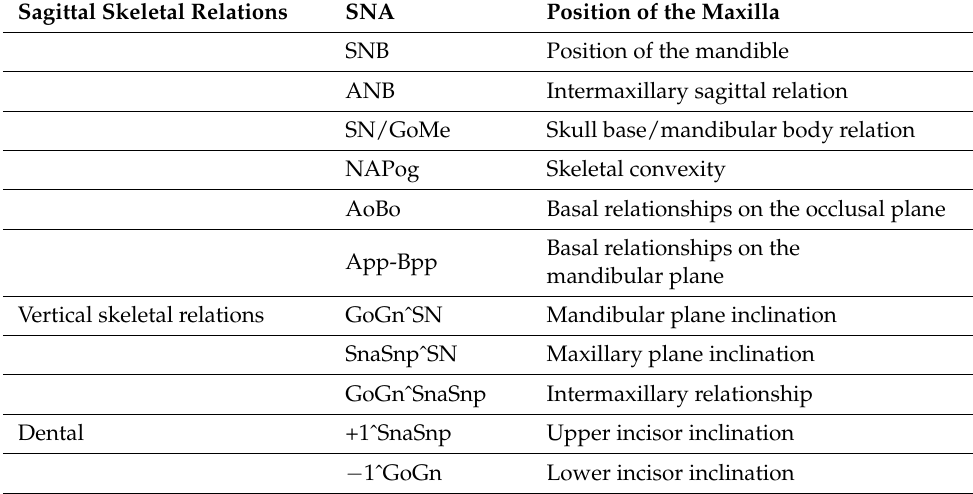
Table 3. Skeletal and dental relationships evaluated in the study. Sagittal Skeletal Relations